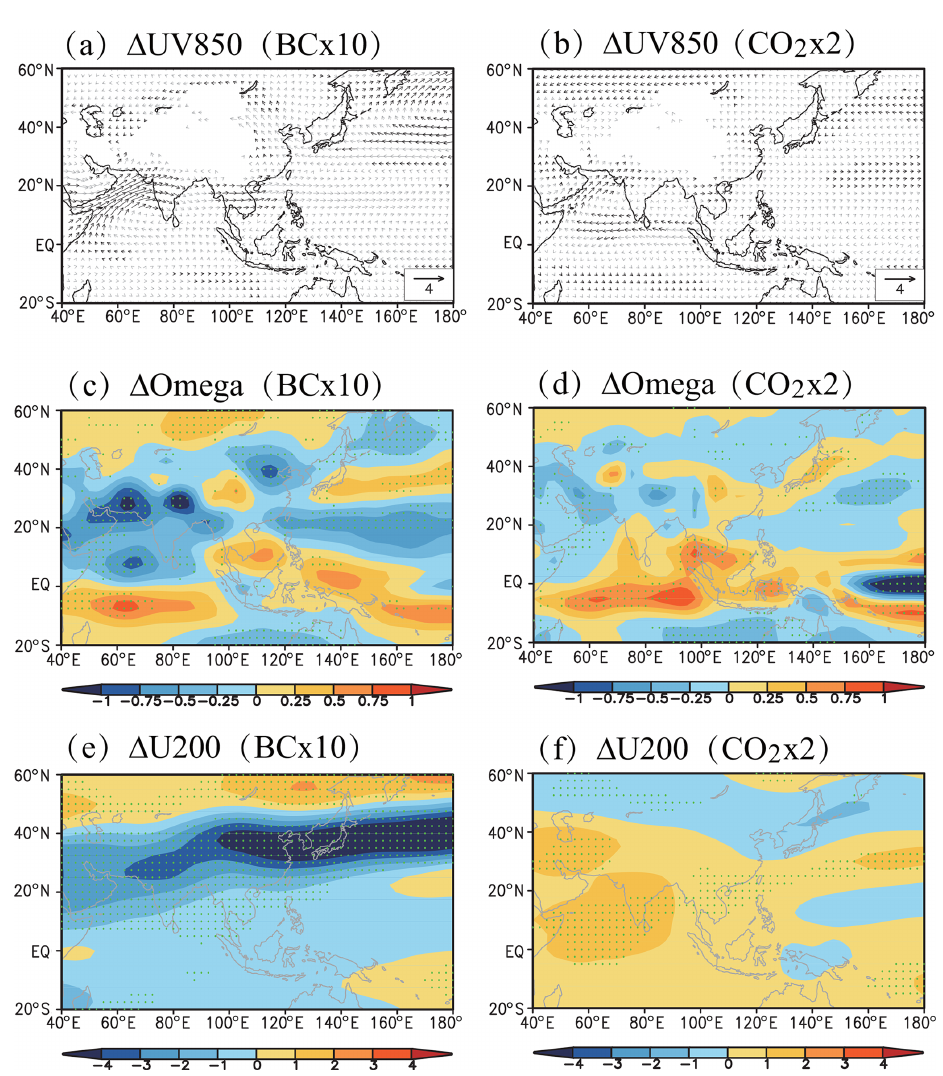
Figure 6. Changes in (a, b) multimodel mean (MMM) of the MJJAS 850hPa wind field ( (cid:49) UV850; unit: ms − 1 ) , (c, d) 500hPa vertical velocity ( (cid:49) Omega; unit: 0 . 01 × Pas − 1 ) and (e, f) 200hPa westerly wind speed ( (cid:49) U200; unit: ms − 1 ) under increasing BC and GHGs. Black arrows (a, b) and dotted regions (c, d, e, f) indicate where the MMM is more than 1 standard deviation away from 0.